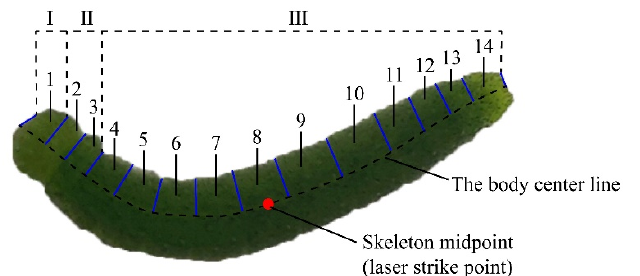
Figure 6. Characteristics of the Pieris rapae larvae and locating the laser strike point. The body of P. rapae larvae can be divided into the head (I), the thorax (II), and the abdomen (III). The numbers 1–14 denote the different segments of the larvae, separated by blue lines.